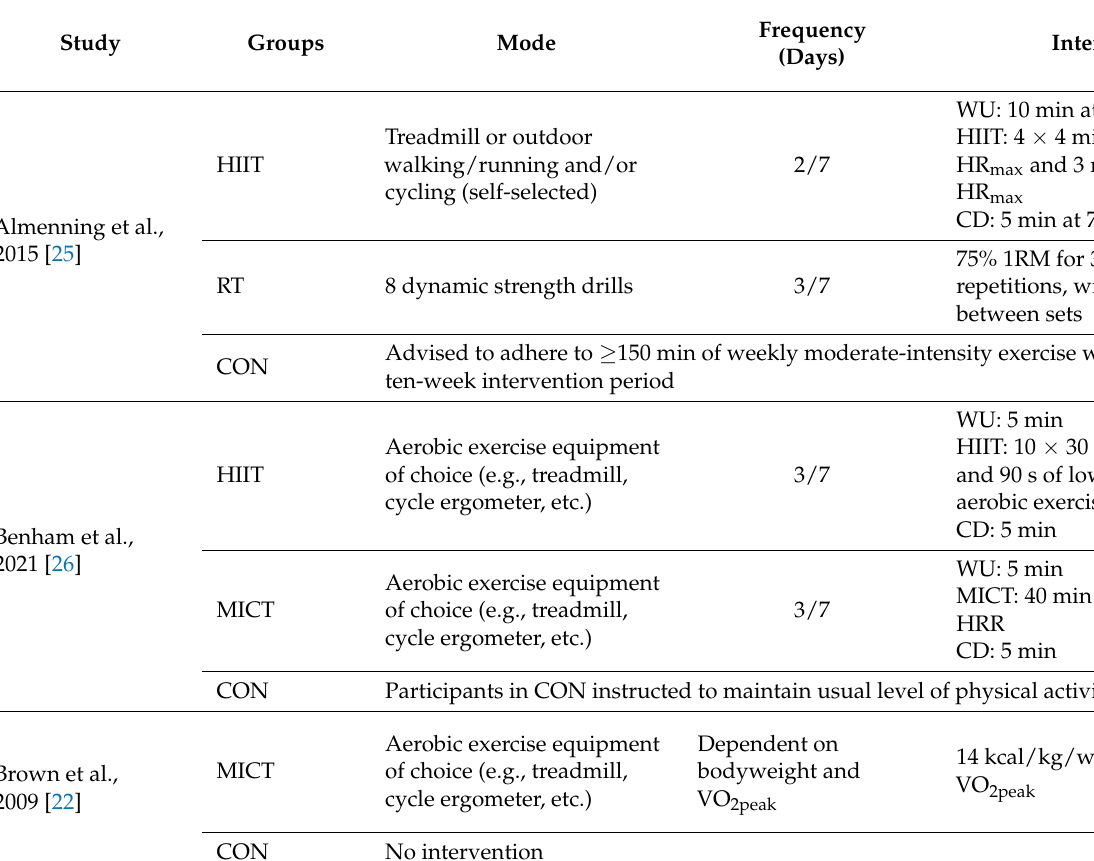
Table 2. Exercise intervention